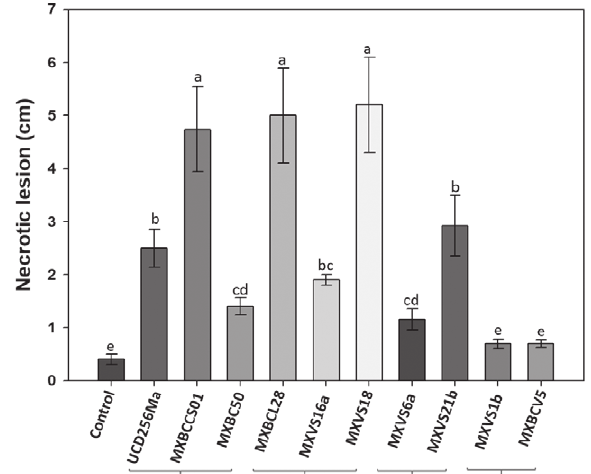
Figure 7. Mean lesion length caused by Lasiodiplodia isolates in grapevine plants 2-months post inoculation under greenhouse con- ditions. Bars indicate the standard deviation of each treatment. Sig- nificance letters were grouped based on Fisher’s analysis (P<0.05); Bars indicate standard deviations. Means accompanied by the same letters are not significantly different (α <